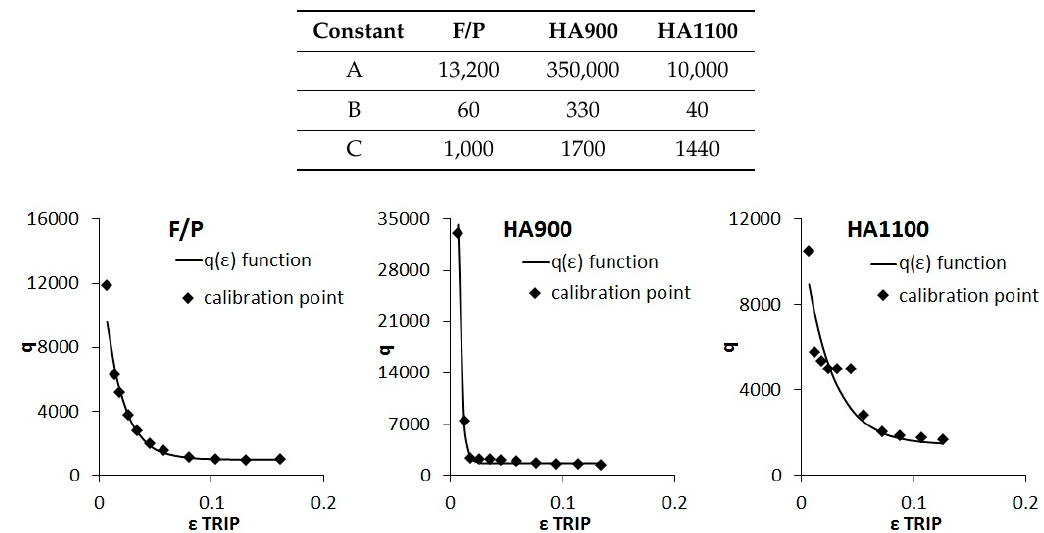
Table 9. Constants for q ( ε ) obtained for each steel.